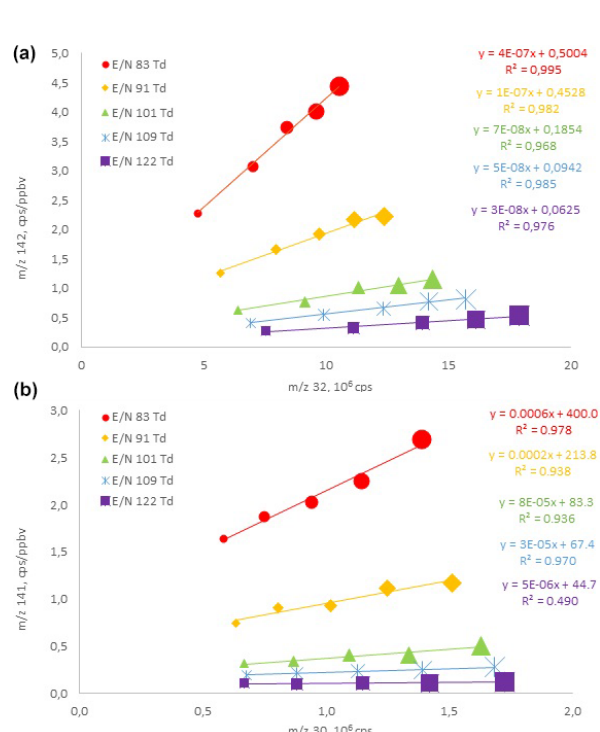
Figure 3. Intensities of (a) m/z 142 (M + , charge transfer) vs. m/z 32 (O + ) for n -decane and (b) m/z 141 ([M − H] + , hydride 2 abstraction) vs. m/z 30 (NO + ) for n -decane. Marker size illustrates the U SO values: smallest is 60V and largest is